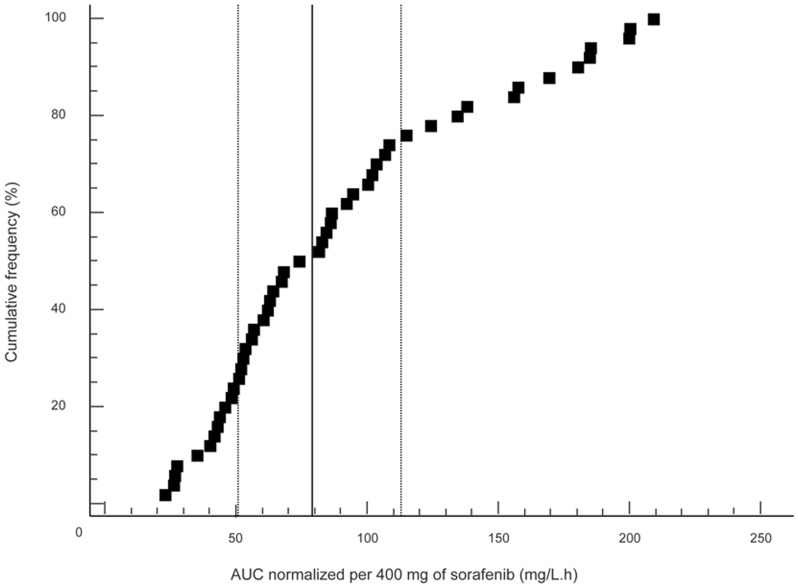
Distribution of sorafenib exposure (AUC) on day 15 after treatment initiation (n = 51).AUC was normalized per 400 mg of sorafenib. The solid line represents the median. The dotted lines represent 25th and 75th percentiles.